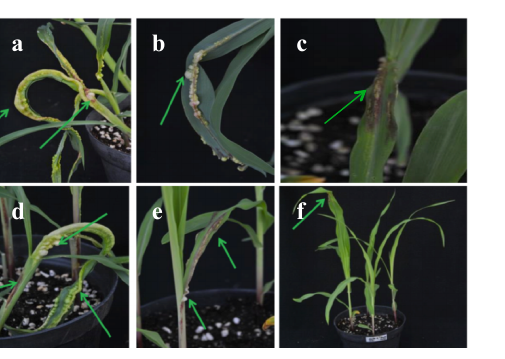
Figure 4. Virulence of ∆ cda1 mutant strain. ( A ) Macroscopic symptoms of plants. ( a ) Morphol- ogy of tumors induced in corn plants by the mixture of wild type strains a1b1 × a2b2 . ( b , c ) Dis- ease symptoms induced by inoculation of the sexually compatible mixtures: a1b1wt × a2b2 ∆ cda1 ; ( d ) a1b1 ∆ cda1 × a2b2wt; and ( e , f ) ∆ cda1 mutants a1b1 × a2b2 . ( B ) For each strain combination, three independent infection experiments were performed in the total of 75 infected plants. Symptoms were scored 14 days after infection (see Methods for details). The color code for disease rating is given at the bottom. Numbers at the right of the bars indicate the average percentage in each disease category. Arrows indicate areas of tumor. Bars represent standard error values. Different letters denote significant differences (ANOVA and Tukey ´ s test were performed, and reliability was